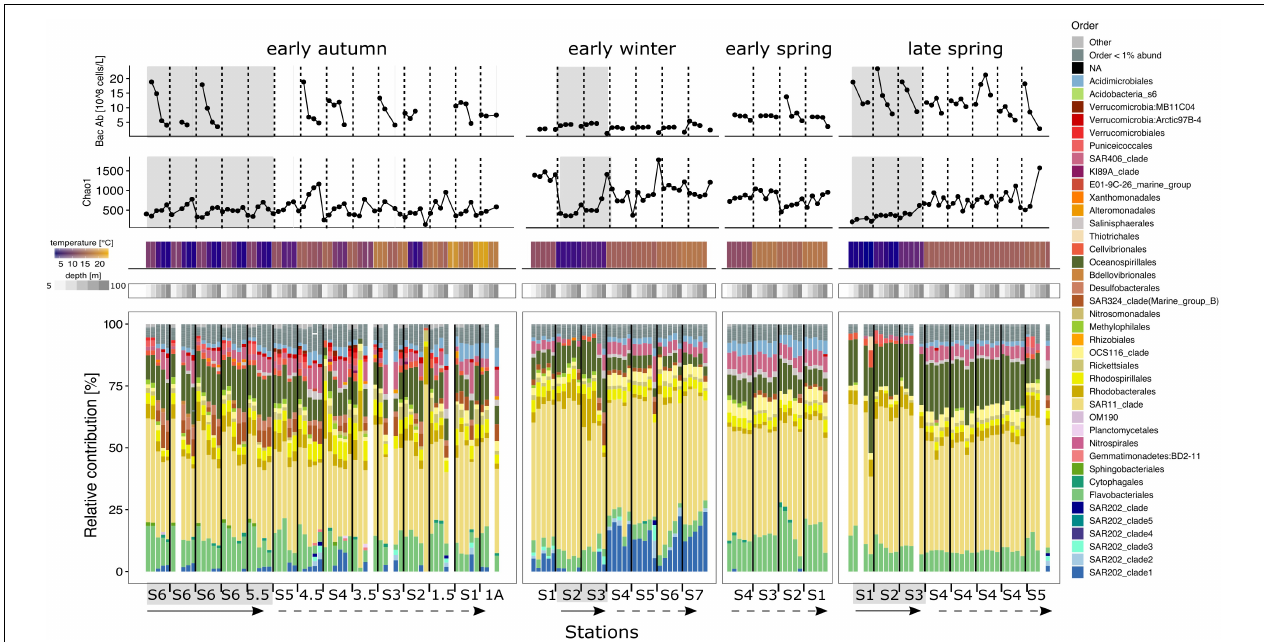
FIGURE 4 | Environmental metadata and stacked bar plots of the taxonomic relative contributions to the bacterioplankton fraction for each station within each seasonal campaign in the euphotic zone. Top two panels: bacterioplankton abundance and Chao 1 richness. Temperature and depth heatmap cells and data points in the three line charts are aligned to the bacteria community composition representation below. Base barplots depict the relative contributions of the different taxonomic groups within the bacterioplankton fraction. Bars are organized by station from left to right in a north to south direction indicated by the straight arrow (subpolar) and the dashed arrow (subpolar), except early winter where S2 was the most northern station. Depths 5–100 m were analyzed and plotted for the bacterioplankton fractions. Within each station, depths are organized in a descending order from 5 to 100 m following a left to right direction. Blank columns represent samples that did not overcame the minimal sequences threshold or which sample was unsuccessful to generate amplicon sequences. Gray background shading indicates that the profile is biologically categorized as subpolar, while no shades represents subtropical.